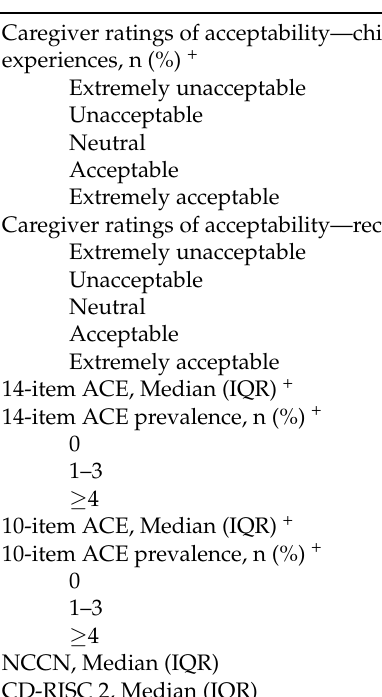
Table 2. Caregiver Study